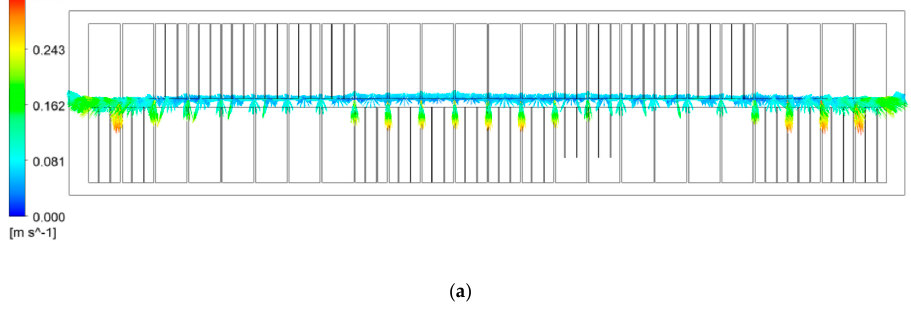
Figure 8. Velocity vectors of the bath flow in the middle horizontal plane of the ACD of Case 1.